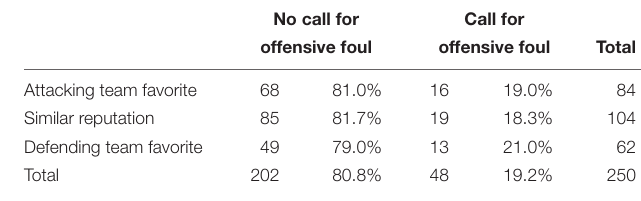
TABLE 4 | Frequency of calls for an offensive foul by the teams’ reputation